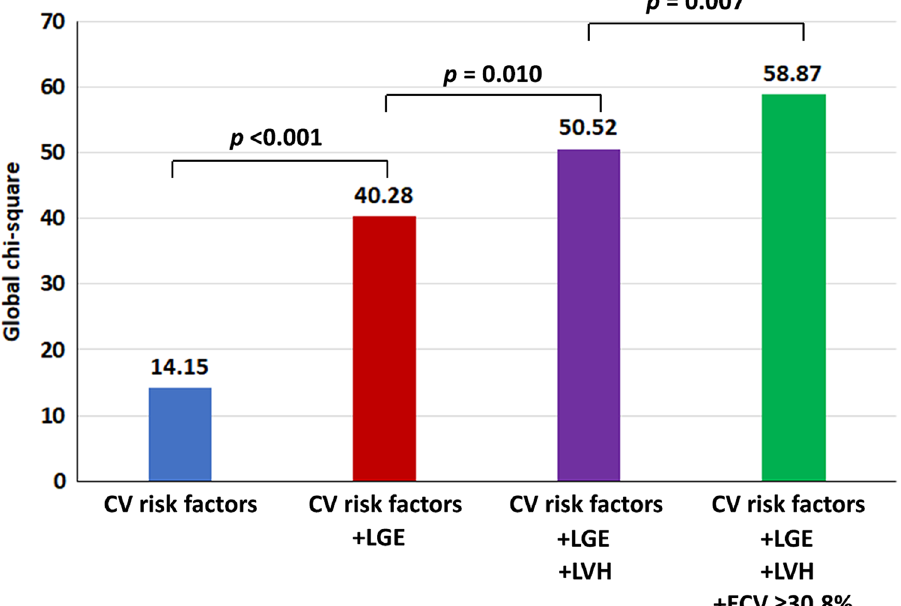
Figure 5. Incremental prognostic value shown as global chi-square values on y-axis of cardiovascular (CV) risk factors, late gadolinium enhancement (LGE), left ventricular hypertrophy (LVH), and extracellular volume fraction (ECV) for composite